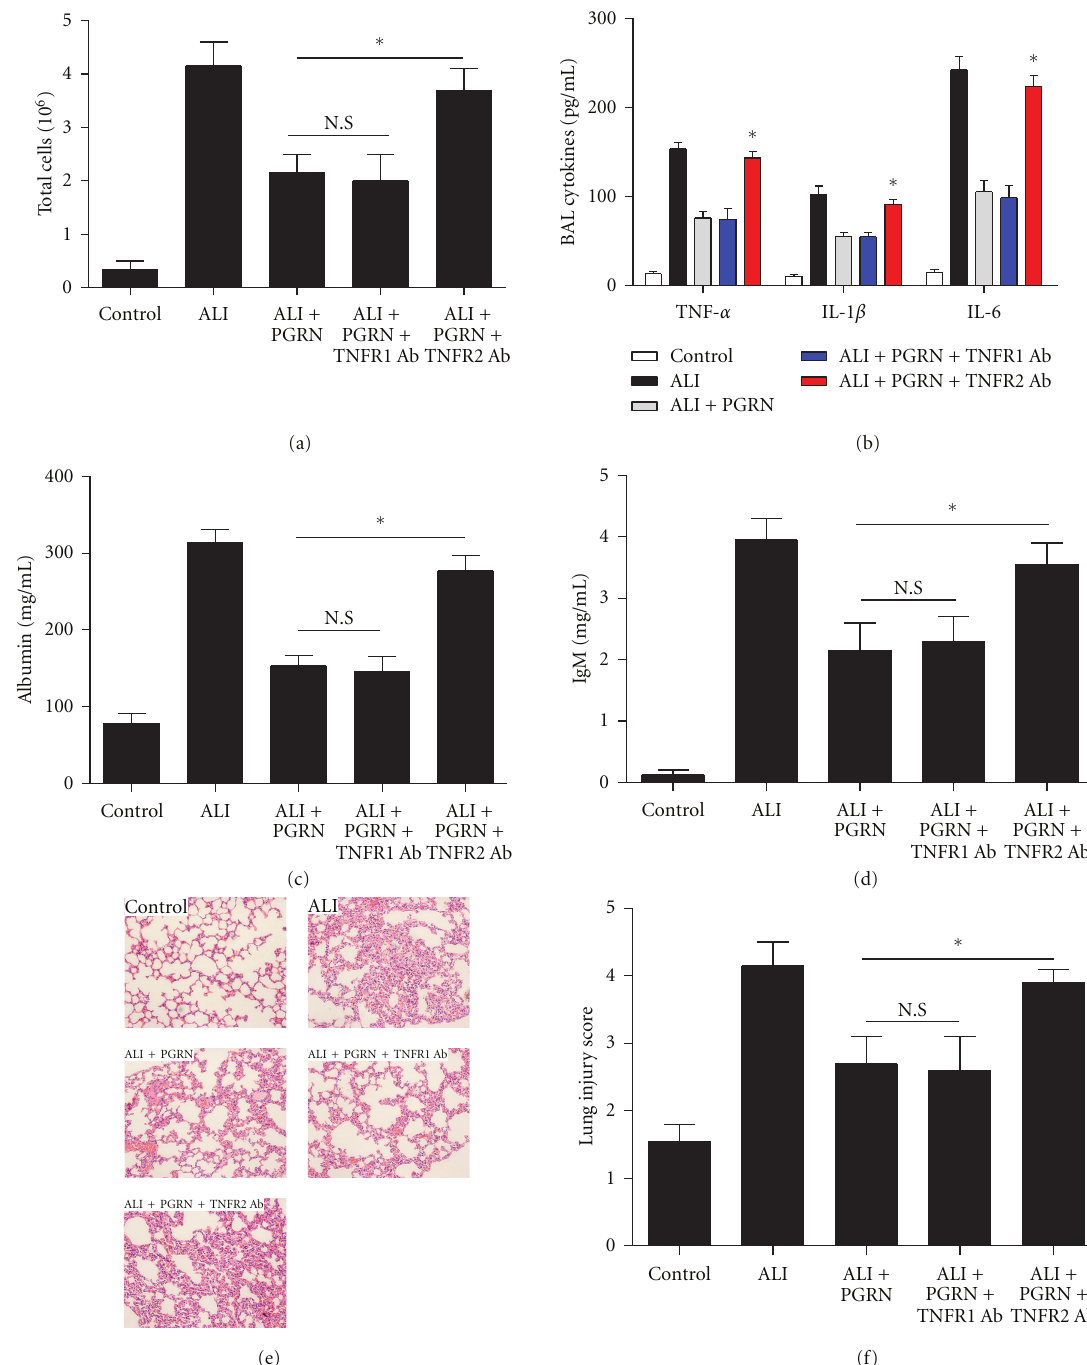
Figure 6: PGRN/TNFR2 interaction was crucial for the protective e ff ect of PGRN on LPS-induced ALI. Groups of mice were pretreated with neutralizing antibodies to TNFR1 or TNFR2, respectively. Twenty-four hours later, the mice were challenged with LPS, followed by administration of PGRN. The total cells (a), proinflammatory cytokines (b), albumin (c), and IgM (d) in BAL fluid was detected at day 3 after LPS challenge. The histological evaluation of lung sections (e) and lung injury score (f) were also analyzed at day 3 after LPS challenge. Data are represented as mean ± standard deviation of one experiment consisting of three replicates. ∗ P < 0 .